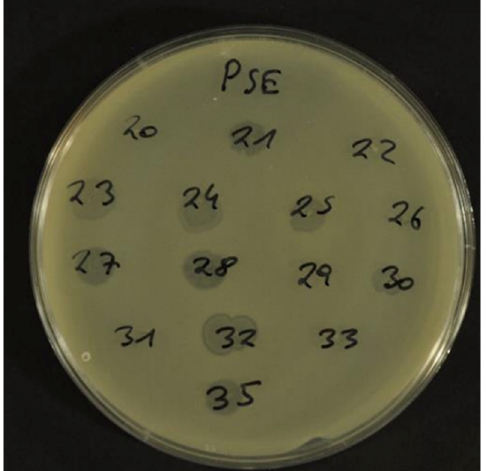
Figure 2. Spot lysis assay on DSM 17420 strain (picture was taken by the authors). Most prophage lysates of the serovar Typhimurium were able to infect food isolates of the serovar Typhimurium, serovar Enteritidis, serovar Heidelberg, serovar Blockley, serovar Hadar, serovar Rissen, serovar Kentucky and serovar Parathyphi. Only two lysates could infect the serovars Blockley and Paratyphi, whereas the serovars Virchow of 44 lysates, respectively (see Table 2). All the data on lysing ability can be found in